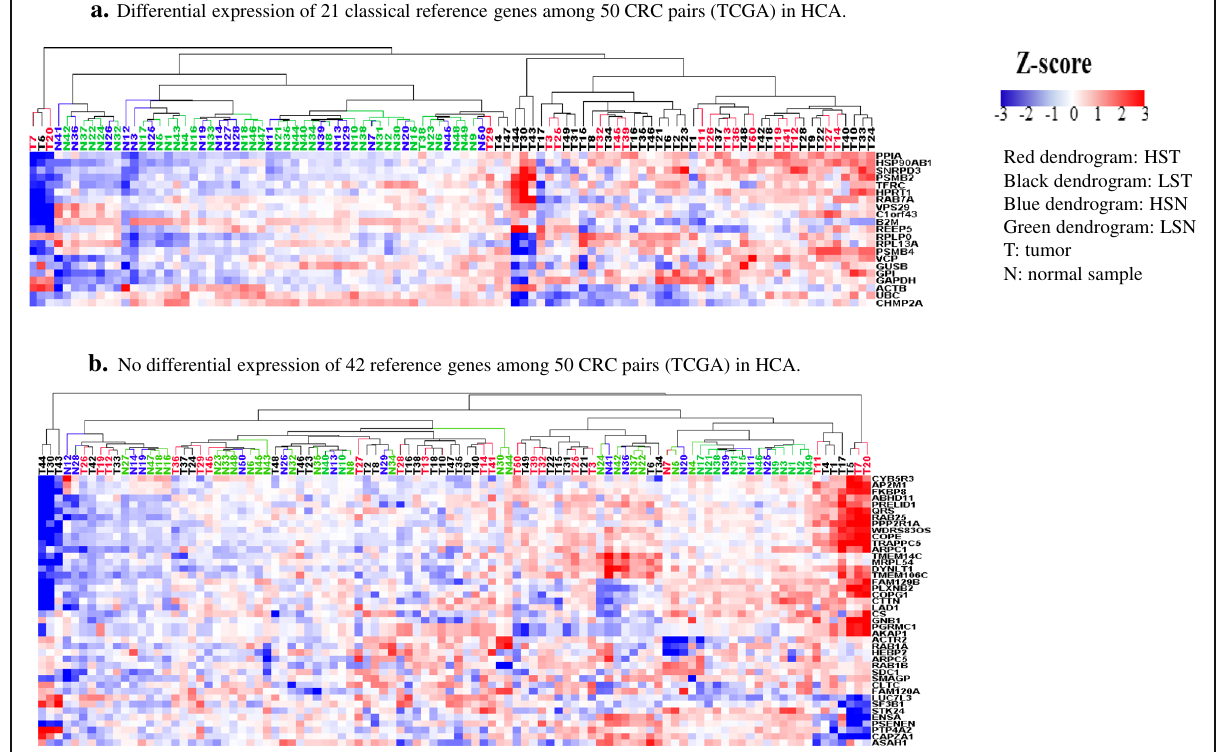
a. Differential expression of 21 classical reference genes among 50 CRC pairs (TCGA) in HCA.